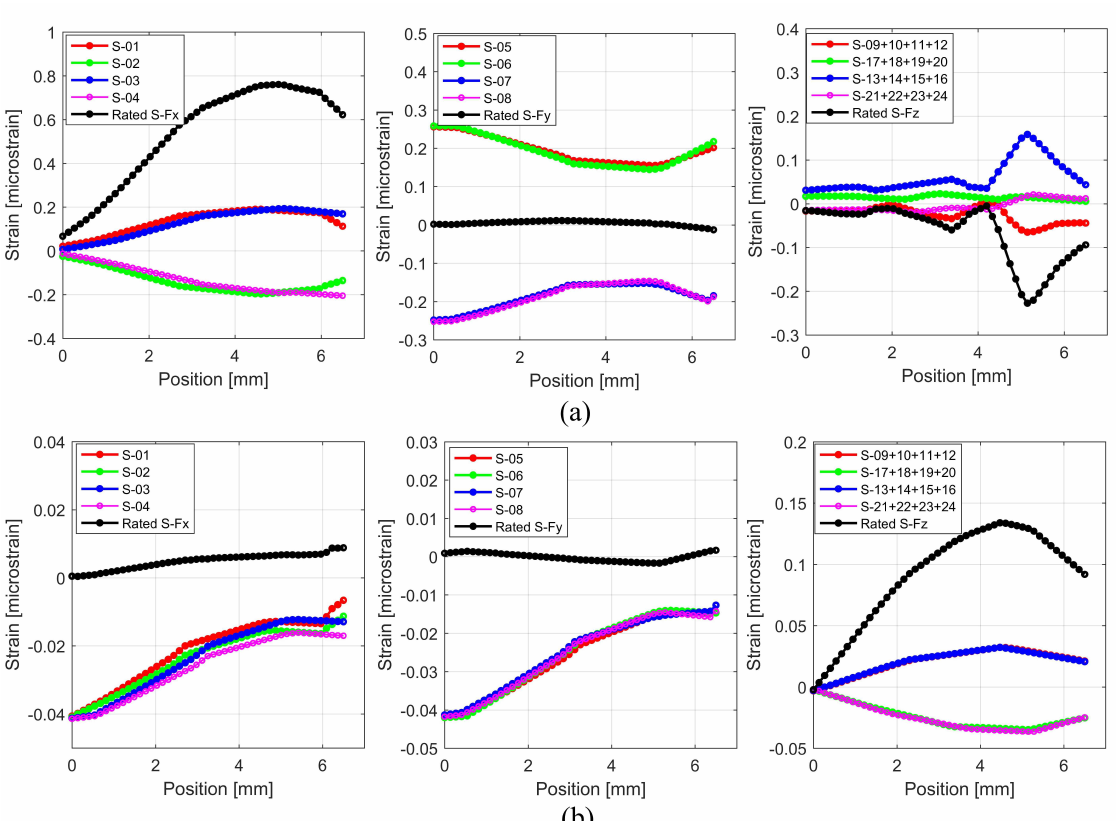
Figure 6. Normal strain along the midline of cross-beam surfaces: ( a ) when F x force is applied; ( b ) when F z force is